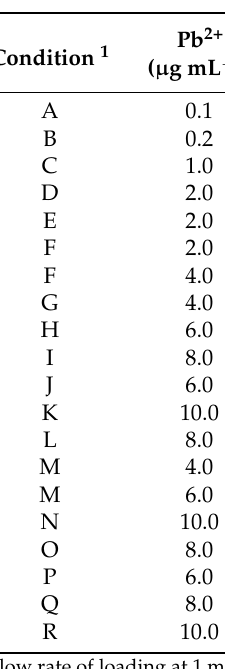
Table 1. Correlation involving the use of single standard calibration.